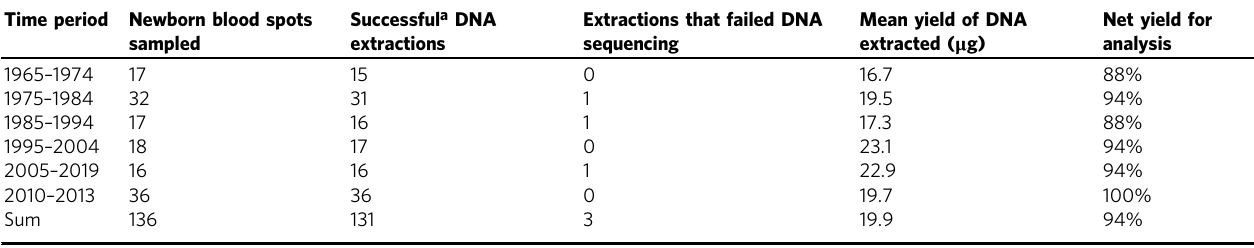
Table 1 Newborn blood spots blood spot DNA extraction and Sanger